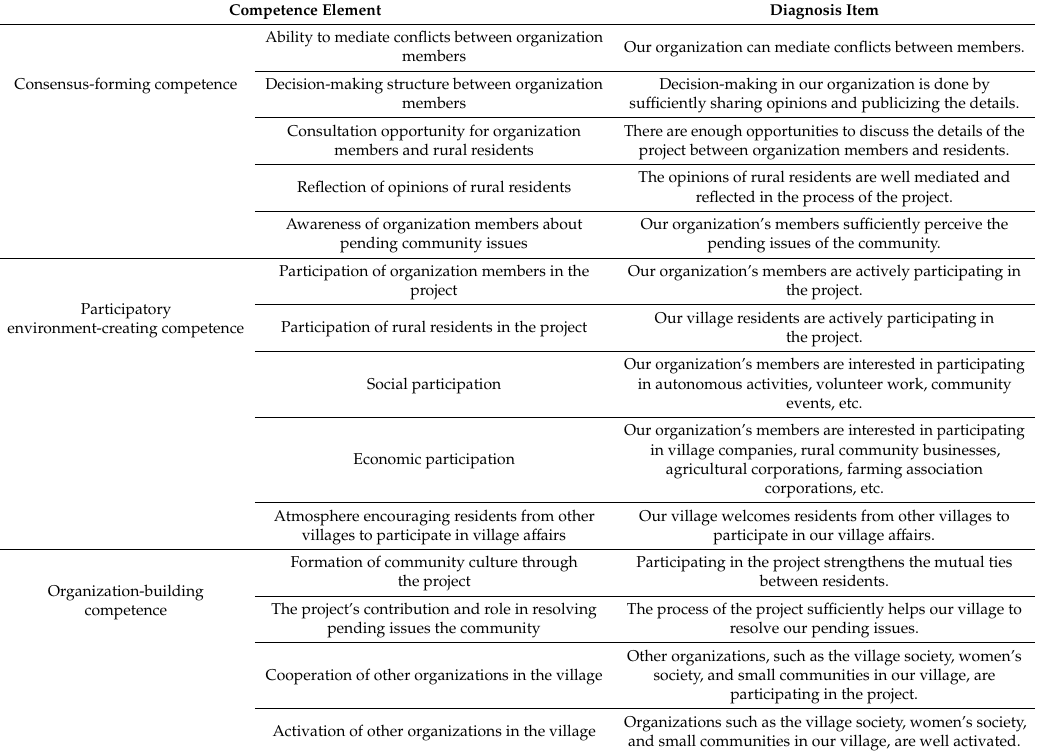
Table 5. The development results with the competence diagnosis